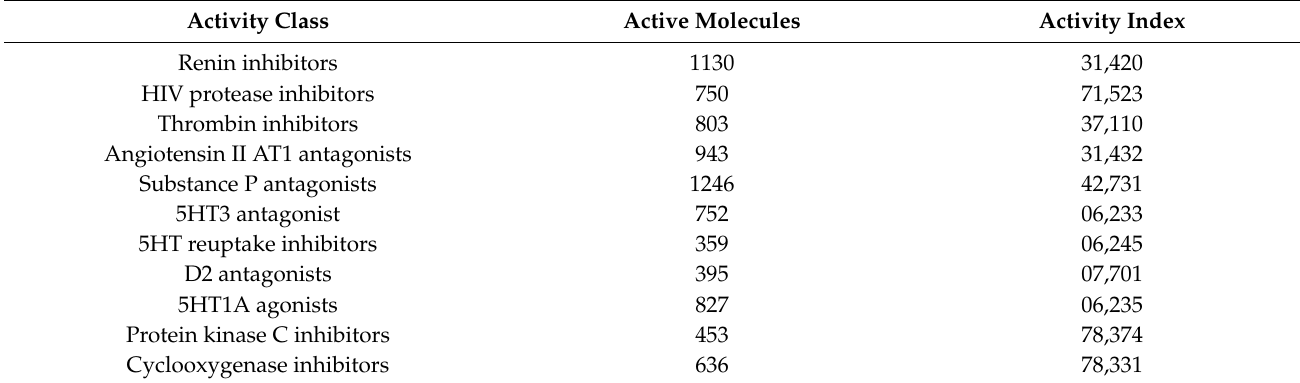
Table 1. The MDDR-DS1 structure activity classes.